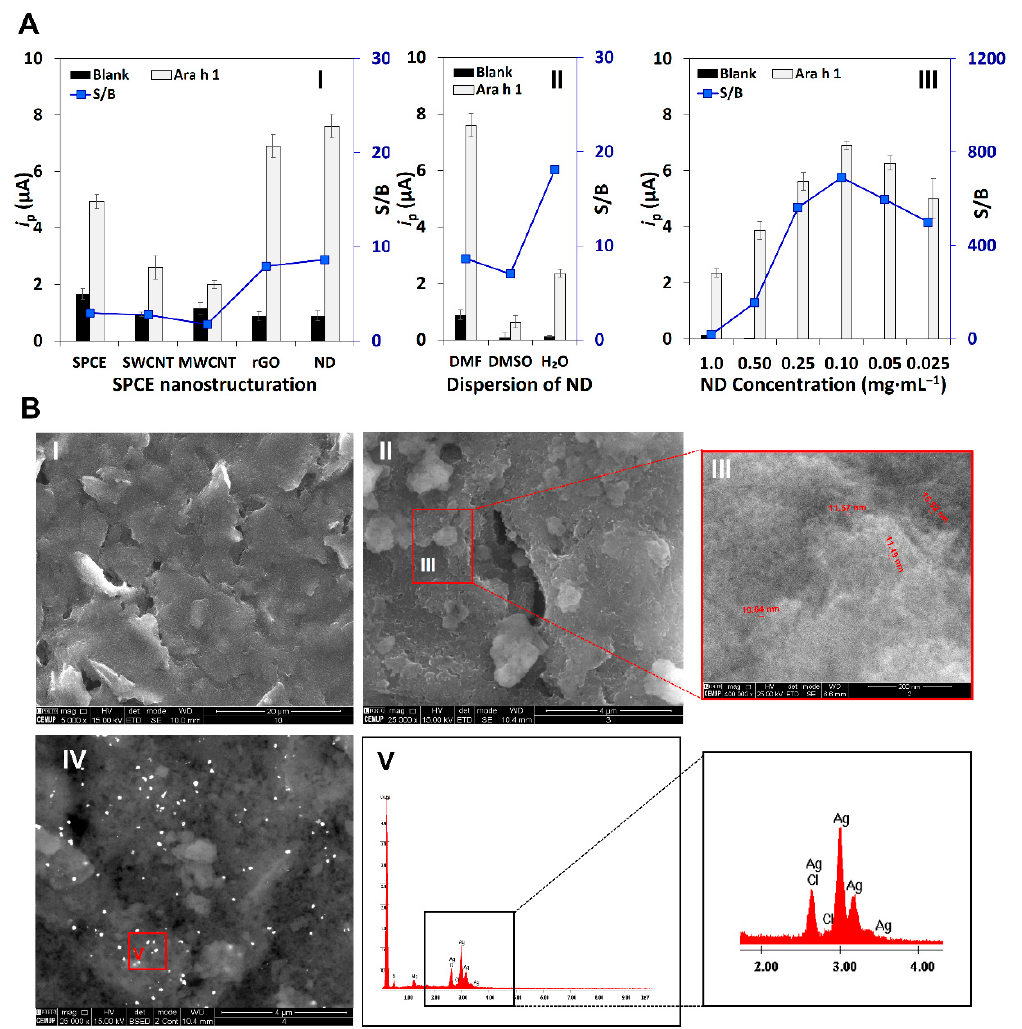
Figure 2. ( A ) Voltammetric analysis: ( I ) SPCE modified with carbon-based nanomaterials (SPCE, SPCE with single-walled nanotubes (SWCNT), multi-walled nanotubes (MWCNT), reduced graphene oxide (rGO), and nanodiamonds (ND)); ( II ) ND dispersed in distinct solvents (DMF, DMSO, and H 2 O); ( III ) ND concentration optimization. ( B ) SEM and EDS analysis: SEM images of ( I ) SPCE (scale bar: 20 µm); ( II ) SPCE/ND (scale bar: 4 µm), ( III ) NDs (scale bar: 200 nm), ( IV ) optimized assay (3IP-Ag + /S-AP/DAb/Ara h 1/CAb/ND modified SPCE; scale bar: 20 µm), and ( V ) EDS analysis of the optimized assay. Experimental conditions: Ara h 1 (0 and 250 ng·mL − 1 ), 3-IP/Ag + (1.0 × 10 − 3 M/4.0 × 10 − 4 M). Error bars are the standard deviation of three replicates.